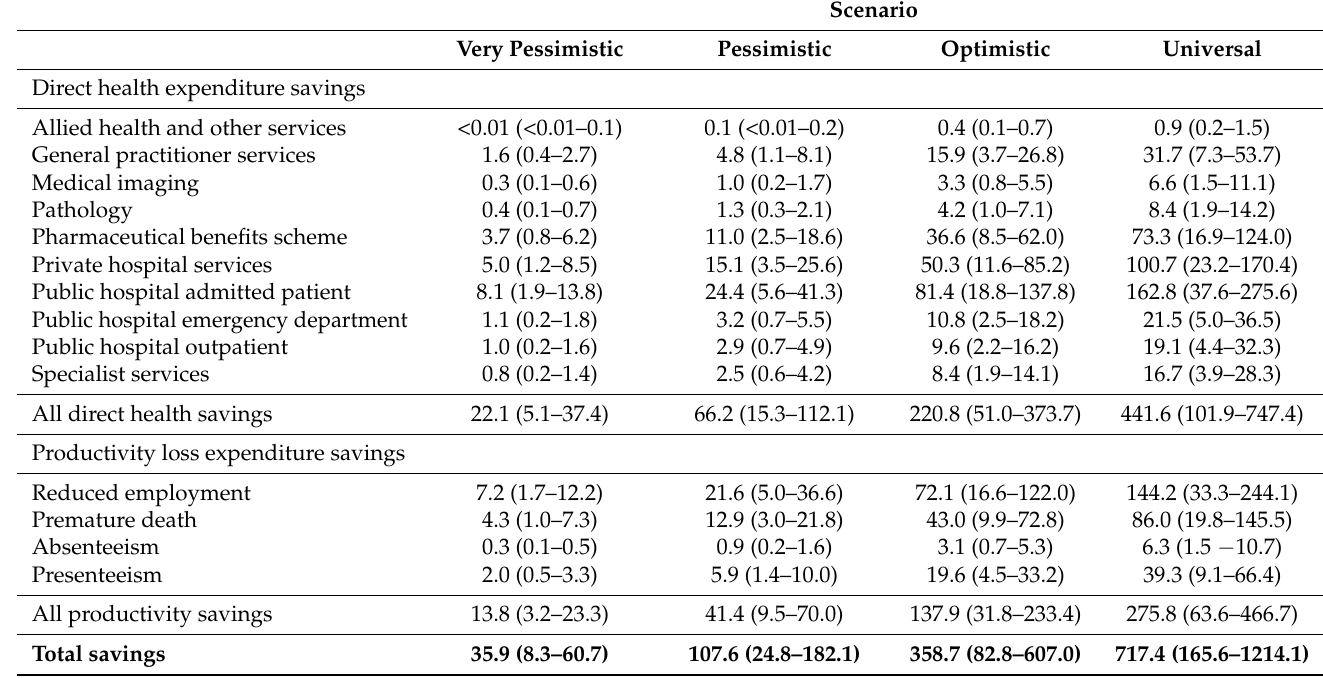
Table 4. Potential annual savings in direct health and productivity loss expenditure of cardiovascular disease in Australian adults (age 20 and over) from whole grain intakes (AUD million) 1